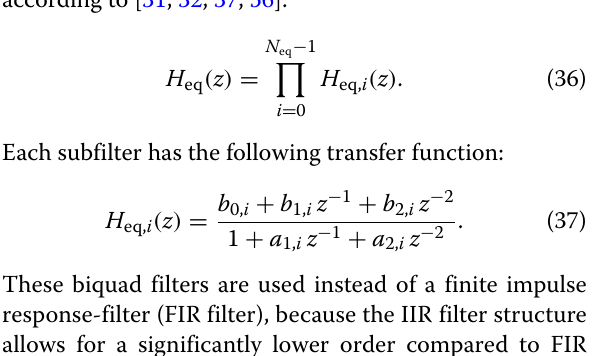
The resulting time-domain signal of the synthesis filter- bank will be denoted here as y fb ( n )